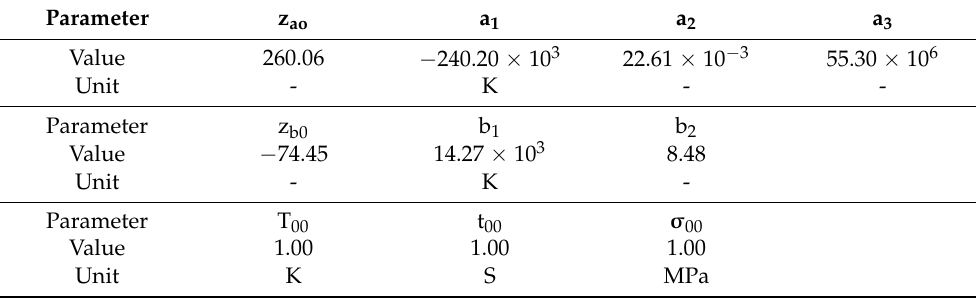
Figure 5. Plotted functions for the parameters ( a ) “a” dependent on aging temperature and aging time and ( b ) “b” dependent on initial stress and relaxation temperature. The parameters z a 0 , z b 0 , a 1 – a 3 , b 1 and b 2 are numerically adjusted and their values are listed in Table 3. T 00 , t 00 , and σ 00 are reference values with the values 1 K, 1 s, and 1 MPa, respectively, to keep the units coherent in the mathematical functions. Table 3. Numerically-adjusted parameters of the phenomenological